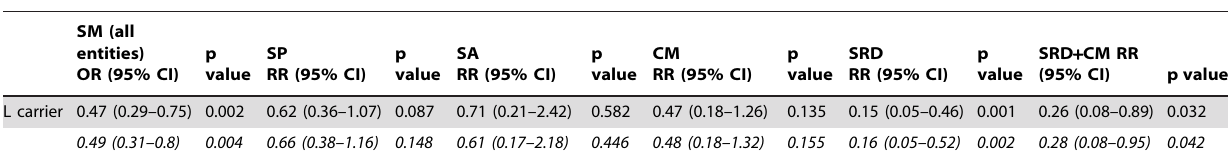
Table 1. Association between L allele containing genotype and different disease entities.